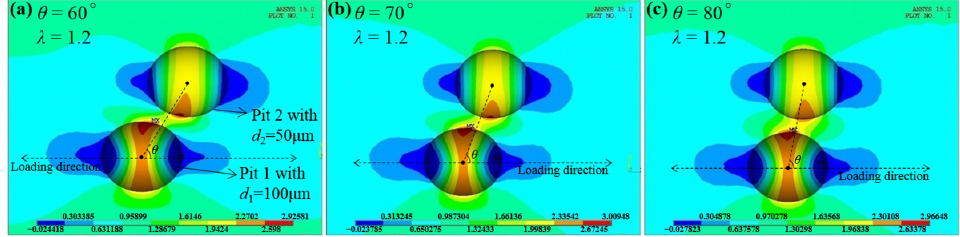
Figure 9. The comparison of stress contours with different θ for the P de -P sh case ( d 1 = 100 μ m, d 2 = 50 μ m) when λ = 1.2, showing the slight asymmetric characteristic that results in the maximum C-SCF (combined stress concentration factor). ( a ) For θ = 60°; ( b ) for θ = 70°; and ( c ) for θ = 80°.